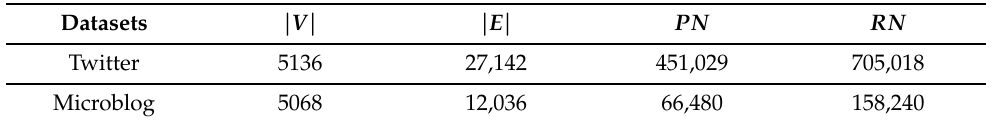
Table 1. Summary of Twitter and Microblog datasets.